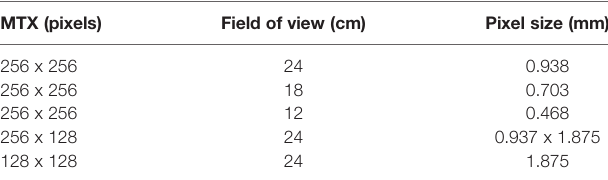
TABLE 1 | Matrices and FOVs studied at 1.5 and 3T with the corresponding pixel size. MTX